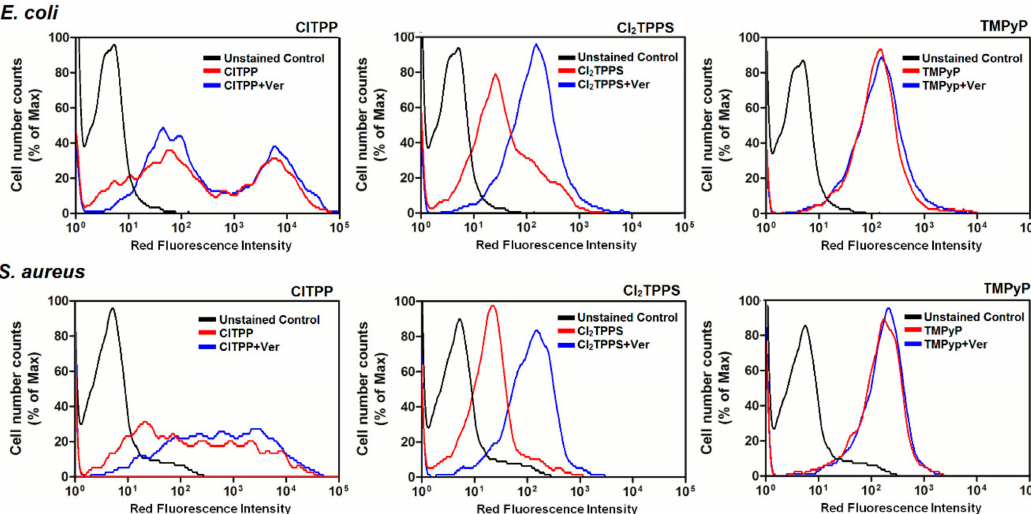
Figure 13. Cellular uptake was determined in E. coli (upper) and S. aureus (lower panel) based on the red fluorescence of the selected porphyrin (ClTPP, Cl 2 TPPS, and TMPyP) using flow cytometry. Histograms of the fluorescence intensities of the unstained control (black line), a photosensitizer (red), and PS uptake after the addition of verapamil